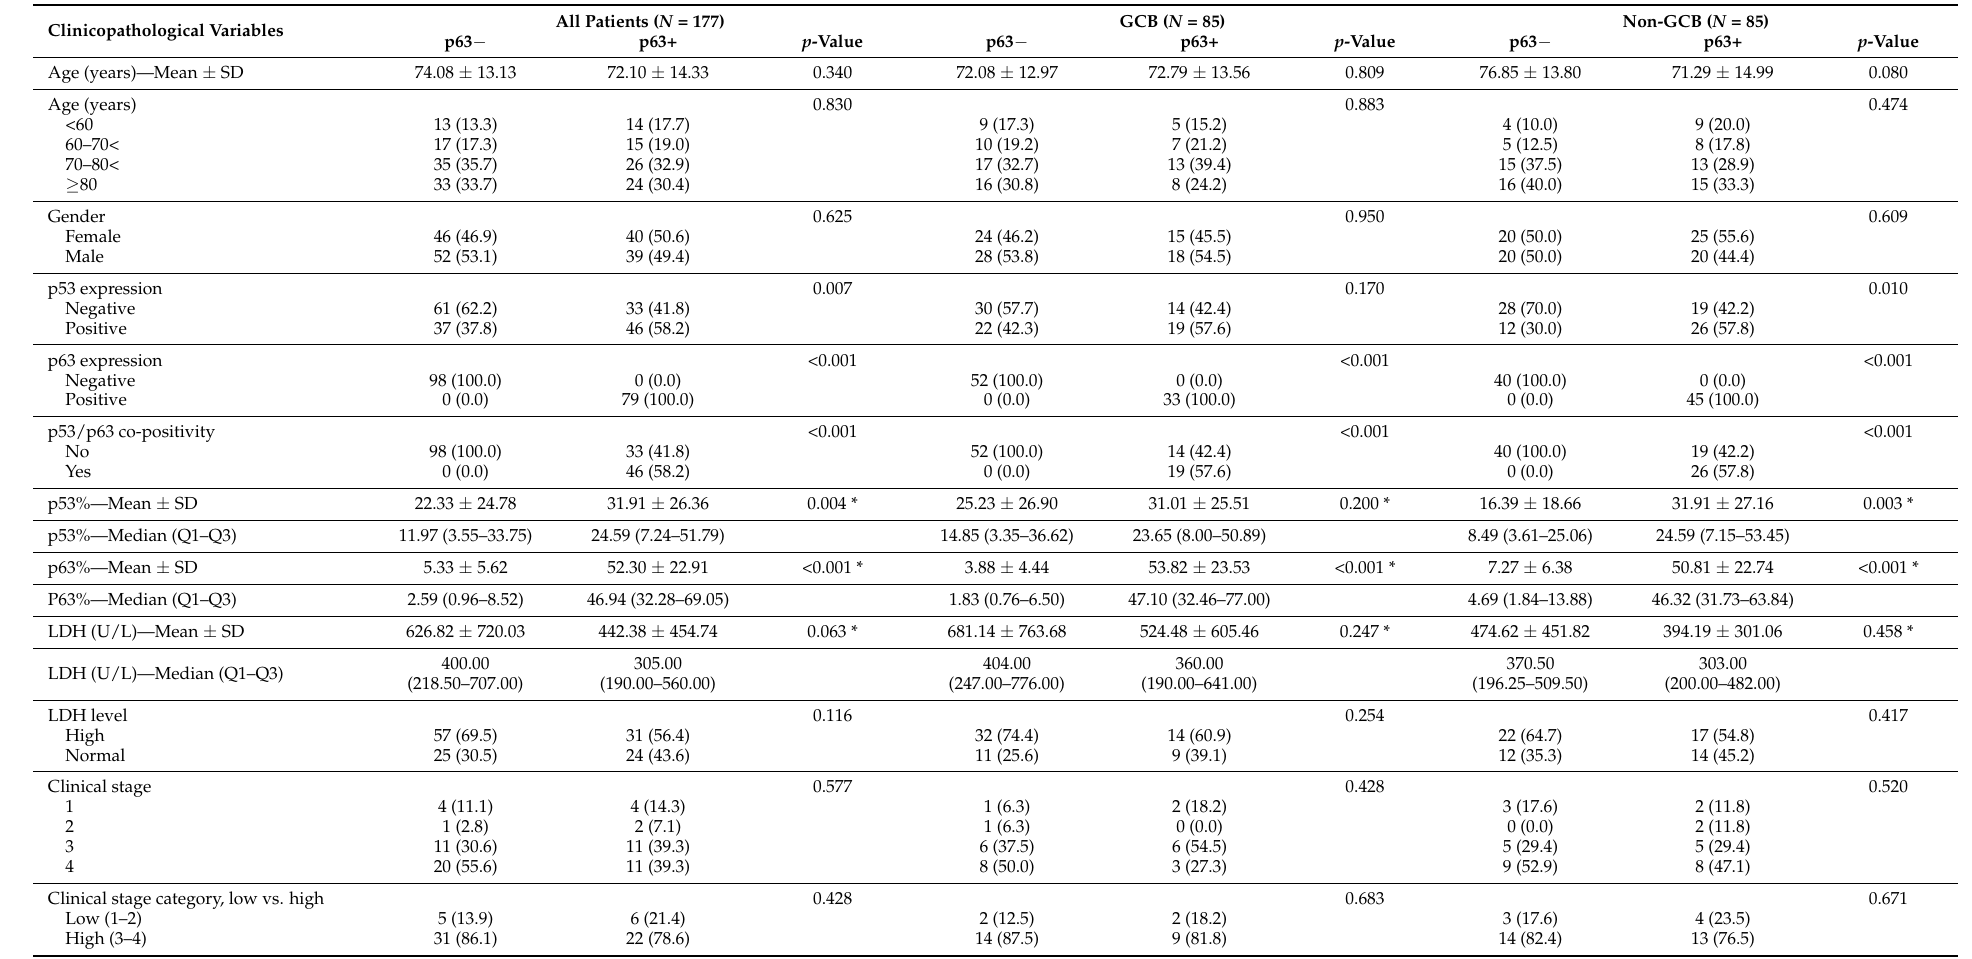
Table 2. Correlation between p63 positivity and clinicopathological characteristics of patients stratified into GCB and non-GCB subgroups ( N =